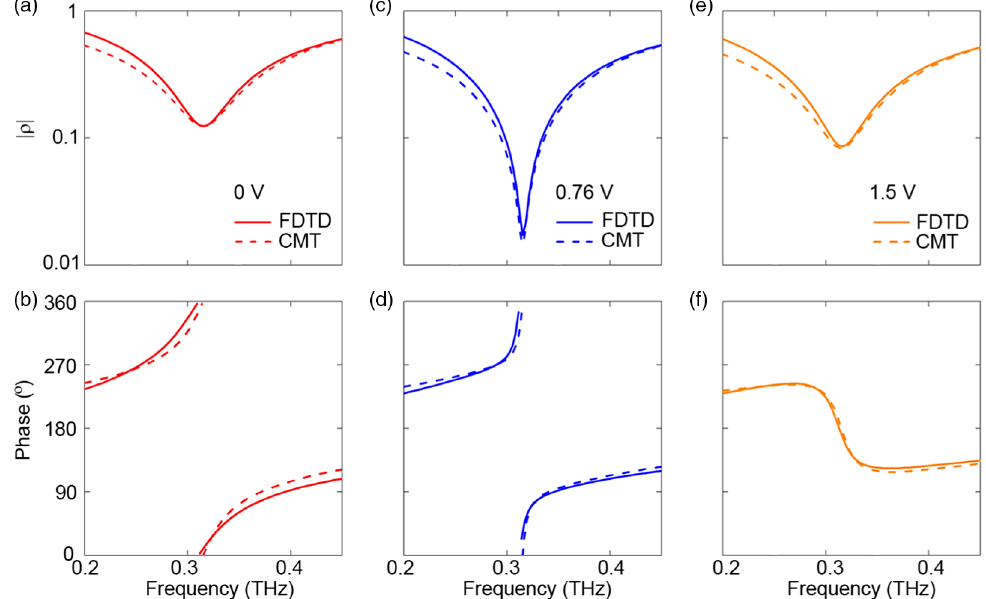
FIG. 9. Reflection spectra calculated from FDTD and CMT results for the 85 - μ m-thick spacer metasurface for different gating voltages. The CMT parameters Γ Γ